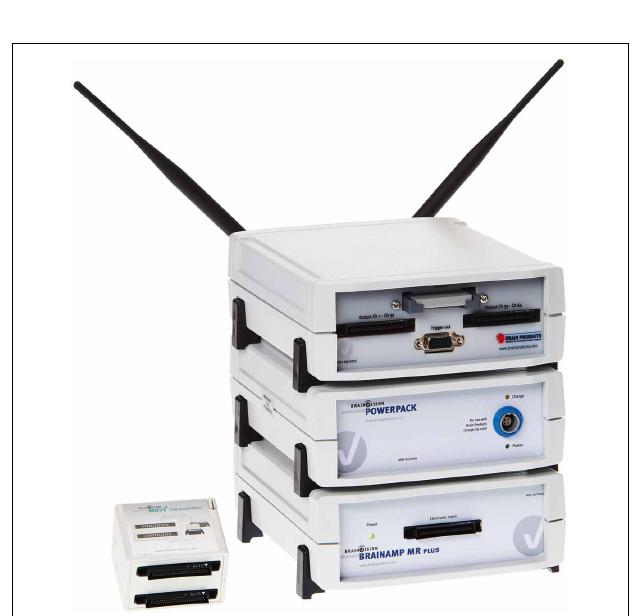
can be moved along the central beam; D, Data cable between EEG cap and the amplifier. The subject (E) can move freely in the measurement volume that is covered by the overhead crane.